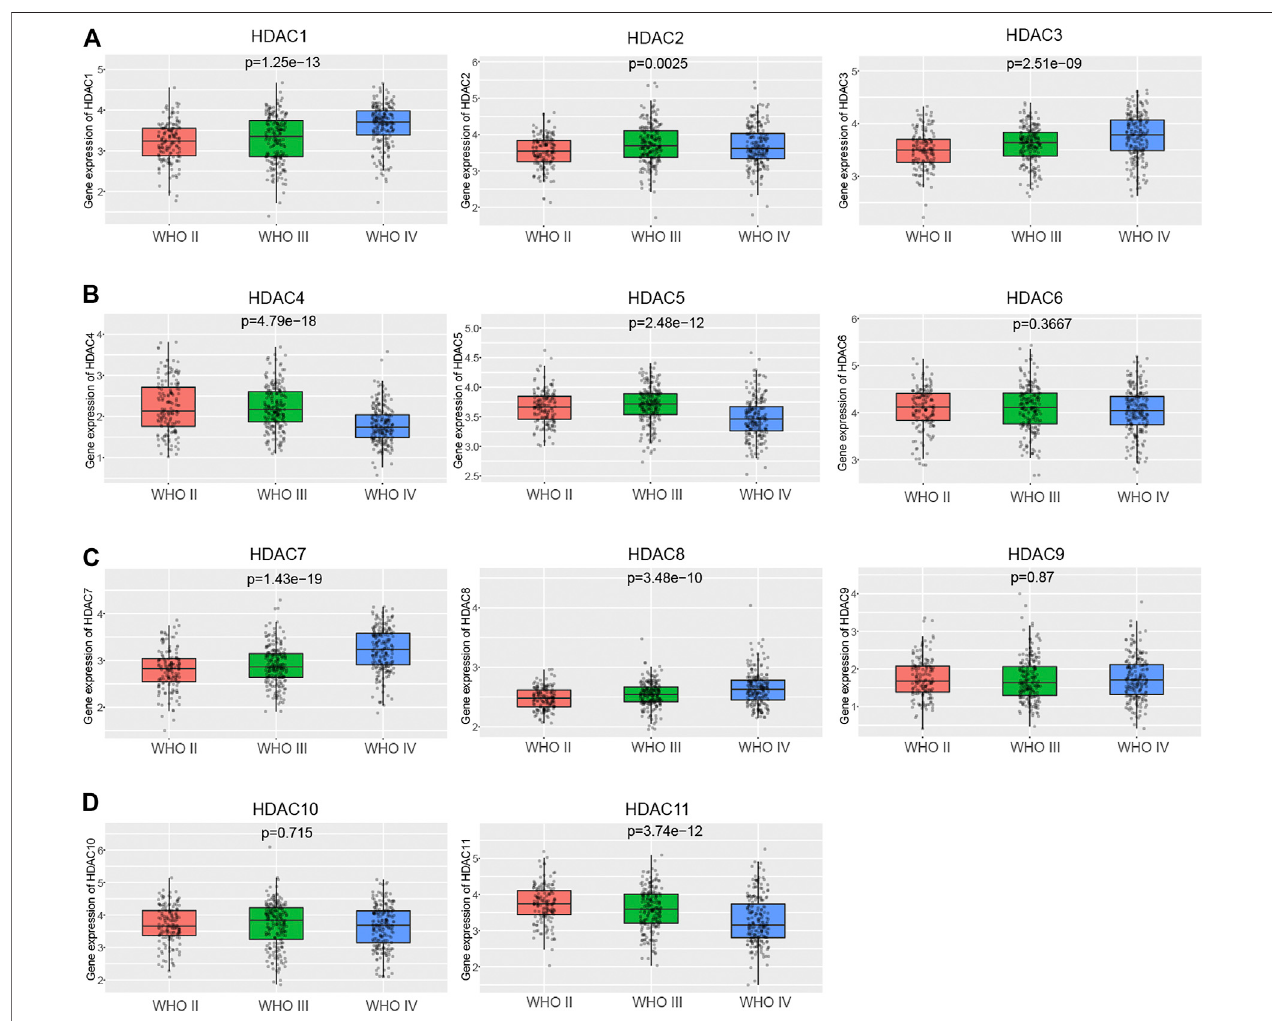
FIGURE 3 | Links between HDAC family and glioma grade in CGGA. (A – D) The box plots depicted that the expression of the HDAC family changed with glioma grade.